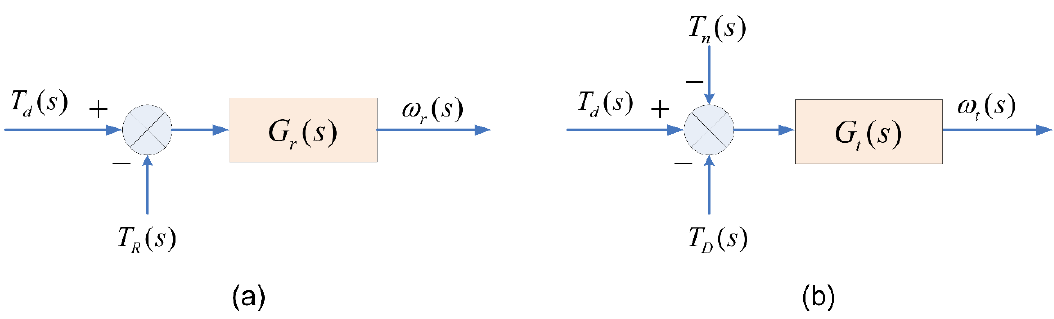
Figure 4. The transfer function model of the vehicle. ( a ) On a real road; ( b ) on a test bench.